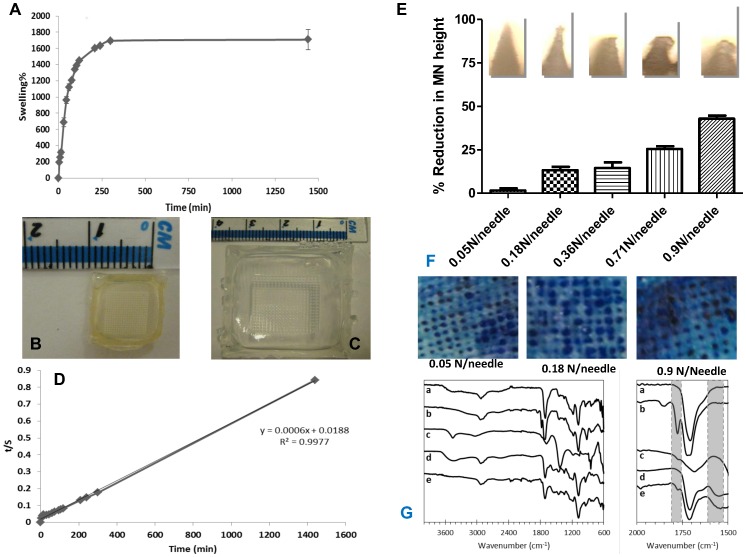
Swelling curve for crosslinked hydrogel films prepared from aqueous blends containing 20% w/w PMVE/MA, 7.5% w/w PEG and 3% Na2CO3 based on the increasing mass of the swelling array expressed as a percentage of the mass of a dry array (Means ± SD, n = 3) (A).Super swelling microneedle arrays prepared from aqueous blends containing 20% w/w PMVE/MA, 7.5% w/w PEG and 3% Na2CO3 as (B) xerogel and (C) post-swelling for 3 hours in PBS pH 7.4. t/S versus t swelling curves of super swelling hydrogel prepared from aqueous blends containing 20% w/w PMVE/MA, 7.5% w/w PEG and 3% Na2CO3 (Mean ± SD, n = 3) (D). Digital microscope images of super swelling hydrogel-forming MN (prepared from aqueous blends containing 20% w/w PMVE/MA, 7.5% PEG 10,000 and 3% Na2CO3) following the application of different forces (0.05, 0.18, 0.36, 0.71 and 0.9 N/needle). These images are representative of the percentage reduction in the heights of needles on the MN arrays observed following the application of the different forces (Means+SD, n = 3) (E). Digital images showing micropores in excised neonatal porcine skin following application of different forces and subsequent staining with methylene blue solution post microneedle removal (F). Attenuated total reflectance (ATR)-Fourier transform infrared (FTIR) spectra of dry hydrogels prepared from aqueous blends containing: 20% w/w Gantrez S-97, 7.5% w/w PEG 10.000 non crosslinked (a) and crosslinked (b) materials; Na2CO3 (c) and 20% w/w Gantrez S-97, 7.5% w/w PEG 10.000 and 3% w/w Na2CO3 non crosslinked (d) and crosslinked (e) materials. The left panel shows a closer view of the carbonyl region for the same materials. A FTIR Accutrac FT/IR-4100 Series (Jasco, Essex, UK) equipped with MIRacle diamond ATR was used at room temperature. Samples were scanned and recorded in the region of 4000–400 cm−1 at a resolution of 4.0 cm−1. The obtained spectra were an average of 64 scans. A standard smoothing process was applied to all the spectra using the equipment software (G).